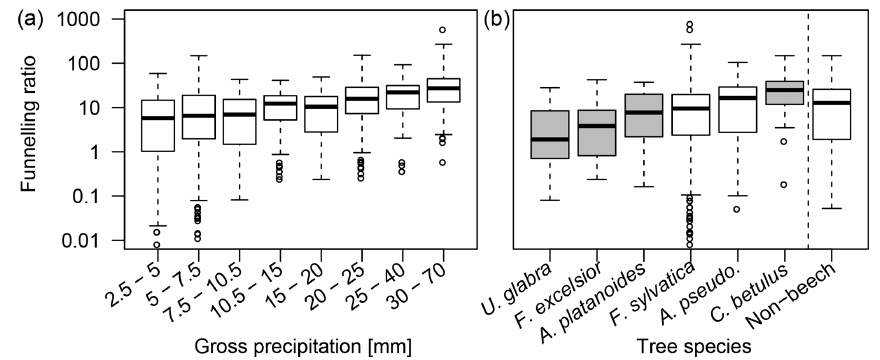
Figure 4. Event funnelling ratios of individual trees ( n = 65), in relation to (a) event gross precipitation and (b) tree species. Grey shaded boxplots contain the data of less than three individual trees.